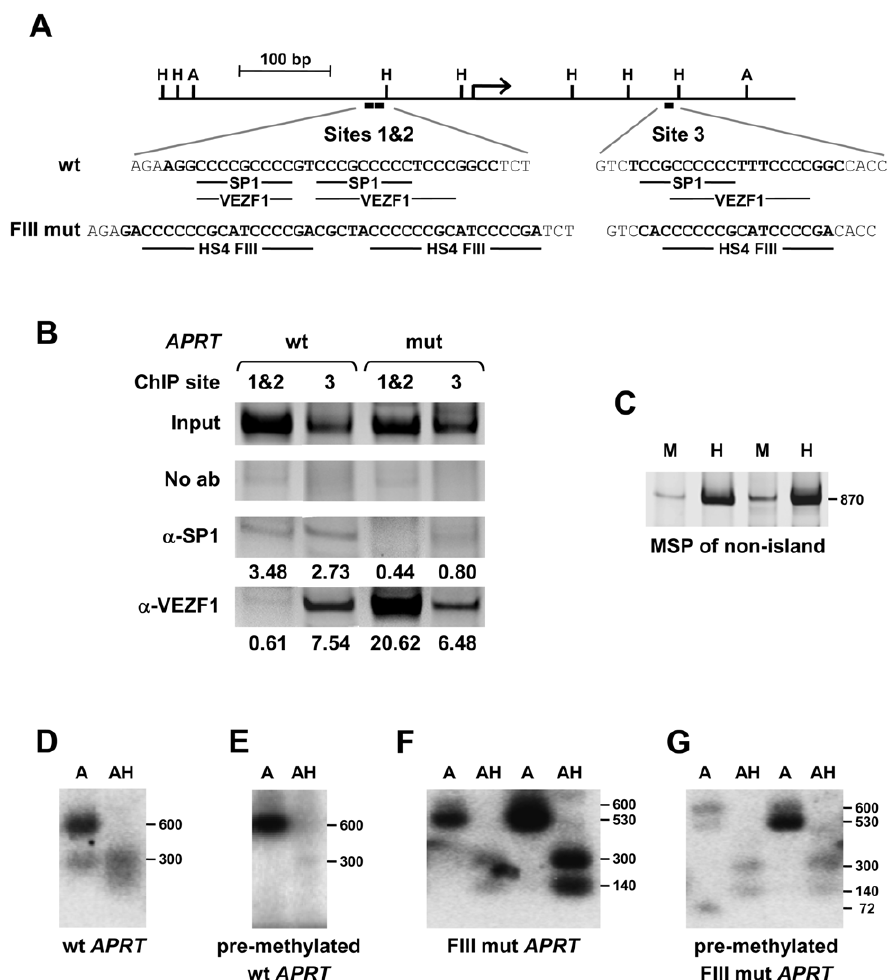
Figure 8. VEZF1 elements protect a CpG island from denovo DNA methylation. (A) Scale representation of the 700 bp hamster APRT CpG island (CGI). The positions of Ava II (A) and Hpa II (H) restriction sites are indicated. The locations of putative SP1 and VEZF1 binding motifs in the wild type (wt) sequence are shown. The sequence alterations in the mutant (mut) are shown beneath, where all three SP1/VEZF1 motifs are replaced with the VEZF1-specific footprint III (CCCCCCGCATCCCCGA) sequence from the HS4 insulator. (B) ChIP analysis of SP1 and VEZF1 interactions with stably integrated hamster APRT CGI sequences in mouse ES cells. PCR primers flanking either sites 1 and 2 (1&2) or site 3 were used to detect interactions with either the wild type (wt) APRT CGI or the mutant (FIII mut) containing VEZF1-specific sites. PCR products shown are , 180 bp in size. DNA enrichments relative to input and normalized to no antibody control are shown (C) Methylation specific PCR (MSP) analysis of a stably integrated non- island region of the APRT locus. Genomic DNA was digested with either of the isoschizomers Msp I (M) or CpG methylation-sensitive Hpa II (H), followed by PCR over the CpG-containing sites. Increased PCR product from Hpa II relative to Msp I digested DNA demonstrates the presence of de novo methylation at these sites in ES cells. Two representative lines are shown. (D–G) VEZF1 sites are sufficient for the demethylation of the APRT CpG island. Southern blotting of APRT CpG island elements stably integrated into ES cells. Genomic DNA was digested with Ava II alone (A) or with Ava II and Hpa II (AH). Digestion of the , 600 bp Ava II parent fragments with Hpa II indicates the absence of DNA methylation. (D,E) Representative lines harboring the wild type APRT CGI that was unmethylated or in vitro methylated with M. Sss I prior to integration. (F,G) Two representative lines harboring the mutant APRT CGI, whose SP1 motifs are substituted with VEZF1-specific FIII sites from HS4, that were unmethylated or pre-methylated prior to integration.